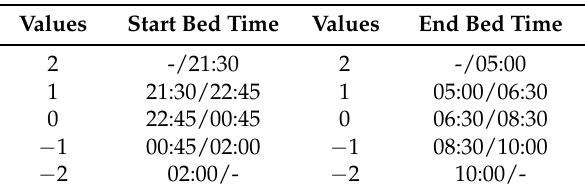
Table 3. Values used to calculate the